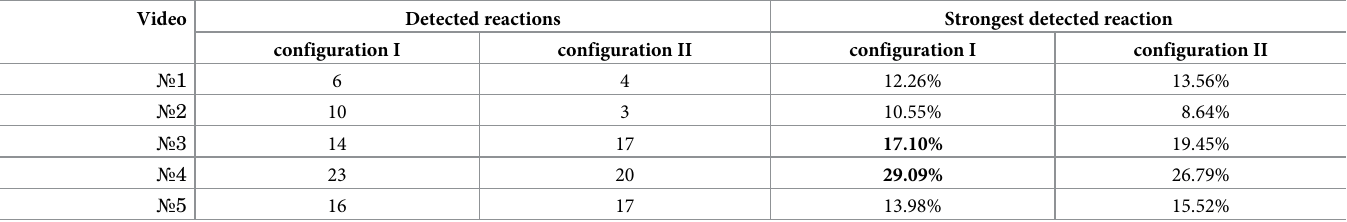
Table 3. Results for the five new videos obtained with the configurations I and II. For each video, the number of reactions per video and the size of the strongest detected reaction in each video are presented.